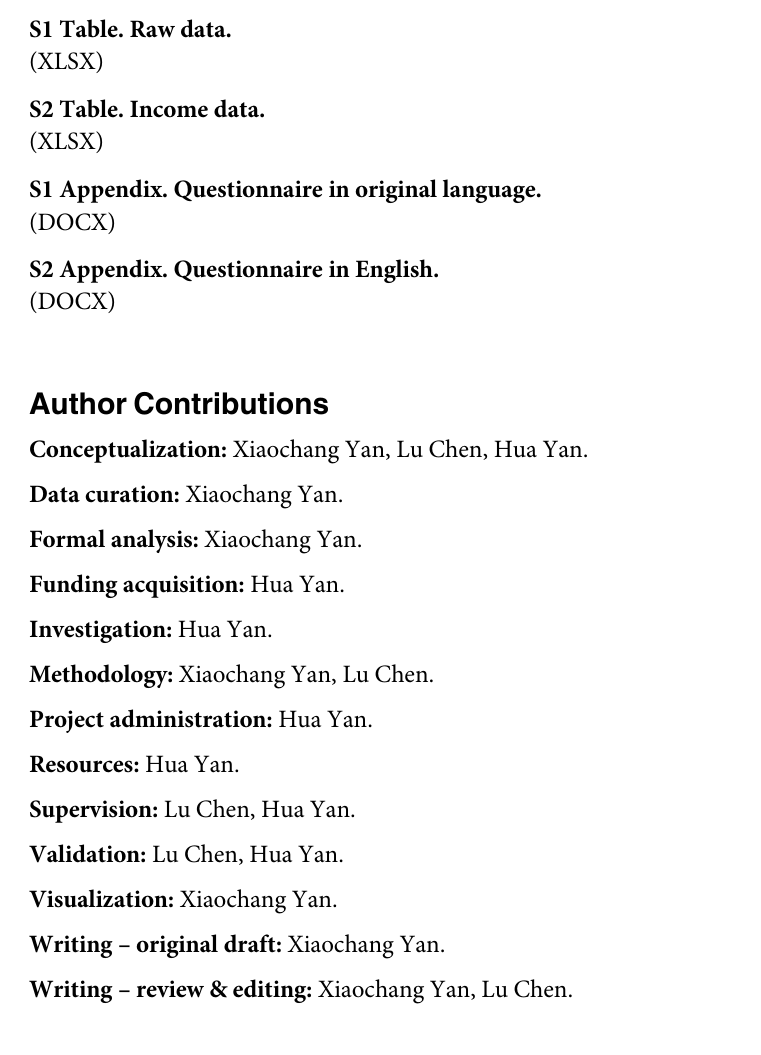
S1 Table. Raw data. (XLSX) S2 Table. Income data.